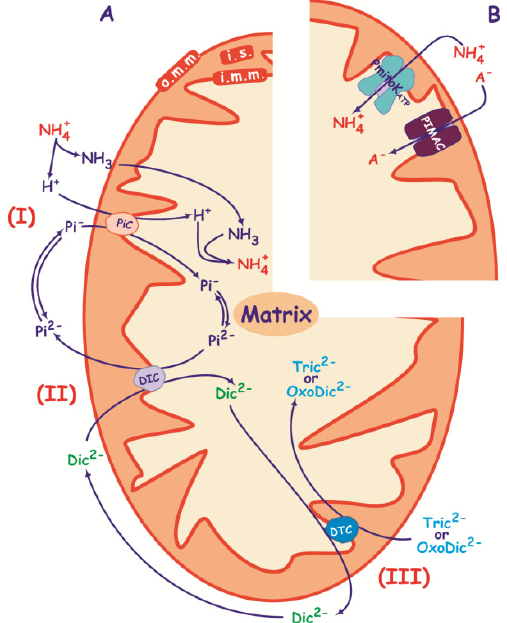
Figure 3. Mechanism of swelling in iso-osmotic solutions of NH 4+ salts according to classical ( A ) and novel ( B ) modes. ( A ) In the first mode, NH diffuses across the 3 associates membrane, down a concentration gradient (I). Inside the mitochondrion, NH 3 with a proton to form NH 4+ . Pi − is transported in symport with H + on the Pi carrier (PiC); in the matrix Pi − is in equilibrium with Pi 2 − that exchanges for dicarboxylate (Dic 2 − ) on the dicarboxylate carrier (DIC) (II), which in turn may exchange for oxodicarboxylate (OxoDic 2 − ) or tricaboxylate (Tric 2 − ) on the dicarboxylate-tricarboxylate carrier (DTC) (III); ( B ) In the second mode, anion (A − ) uptake may be mediated by PIMAC, whereas NH 4+ . i.m.m., inner mitochondrial membrane; i.s., intermembrane is transported via PmitoK ATP space; o.m.m., outer mitochondrial